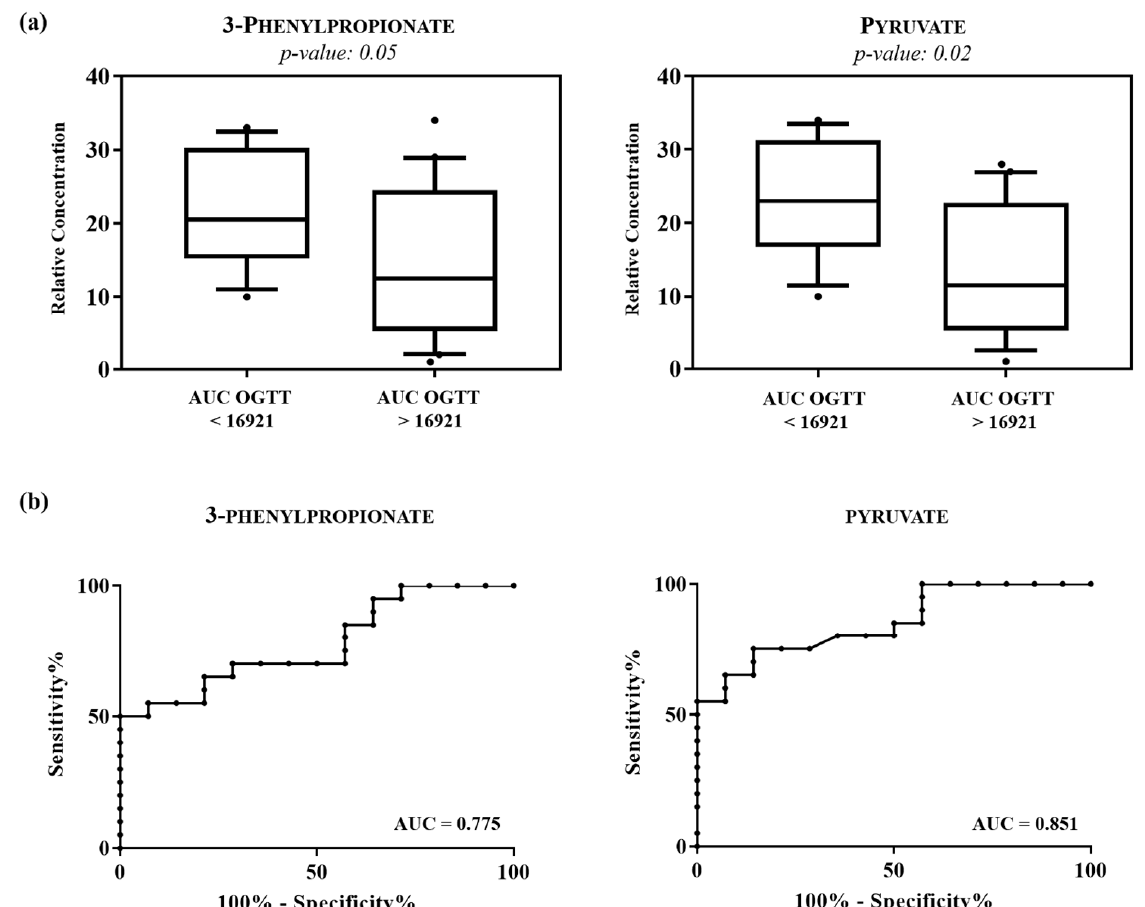
Figure 3. ( a ) Box-and-whisker plots show progressive changes of the urine metabolite levels on subjects with AUC OGTT < 16,921 and AUC OGTT > 16,921. Statistical significance was determined using the Mann-Whitney U test and a p -value < 0.05 was considered statistically significant. The Benjamini-Hochberg adjustment was applied. ( b ) Representative ROC curves built for each altered metabolite in AUC OGTT < 16,921 compared with AUC OGTT > 16,921.